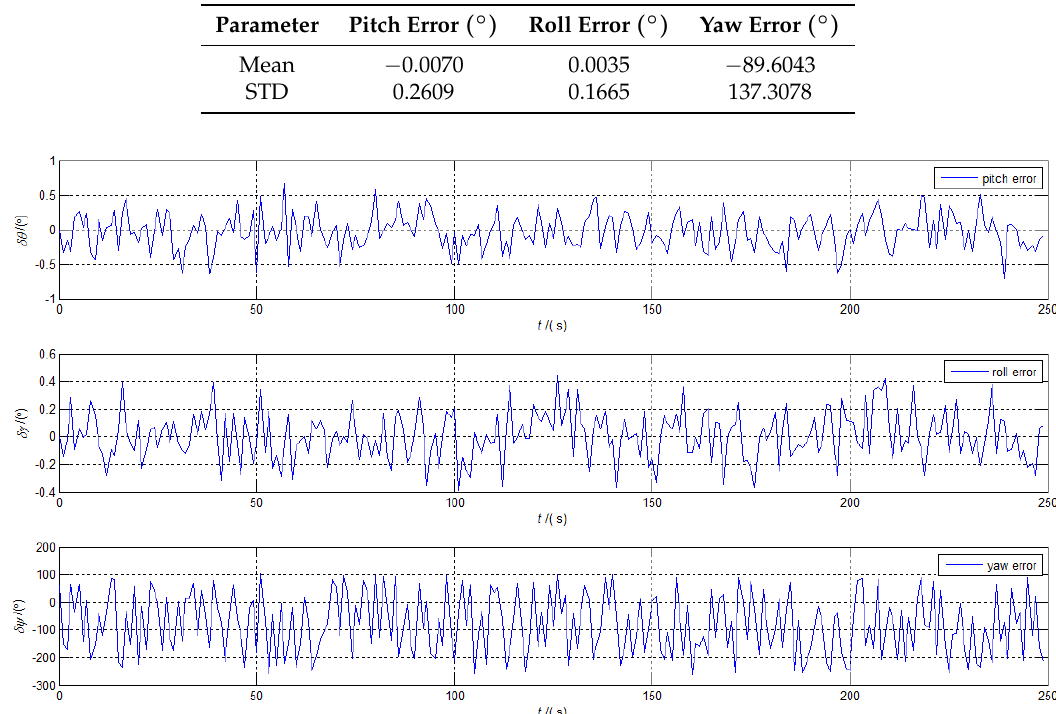
Table 2. Means and STDs of the alignment errors from 240 s–250 s.